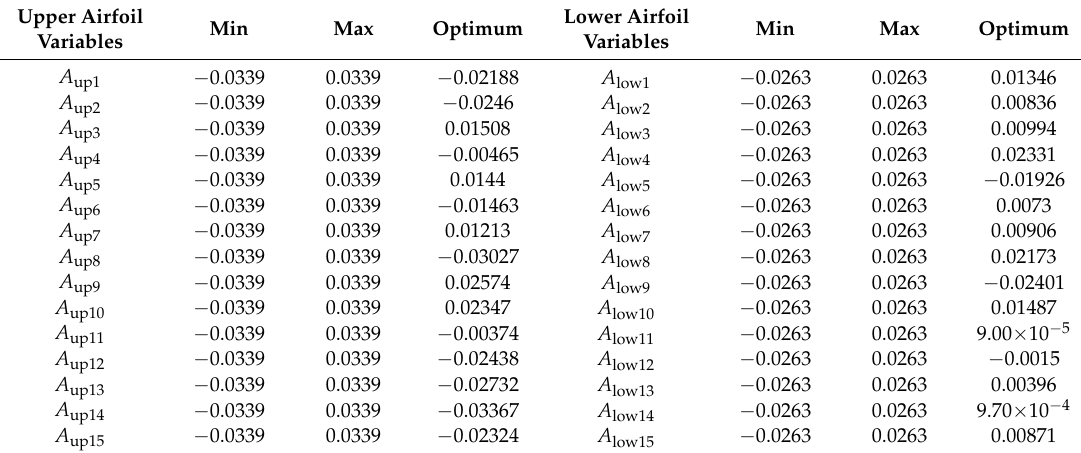
Figure 20. Comparison between initial and optimized airfoil. Table 3. Optimization results.